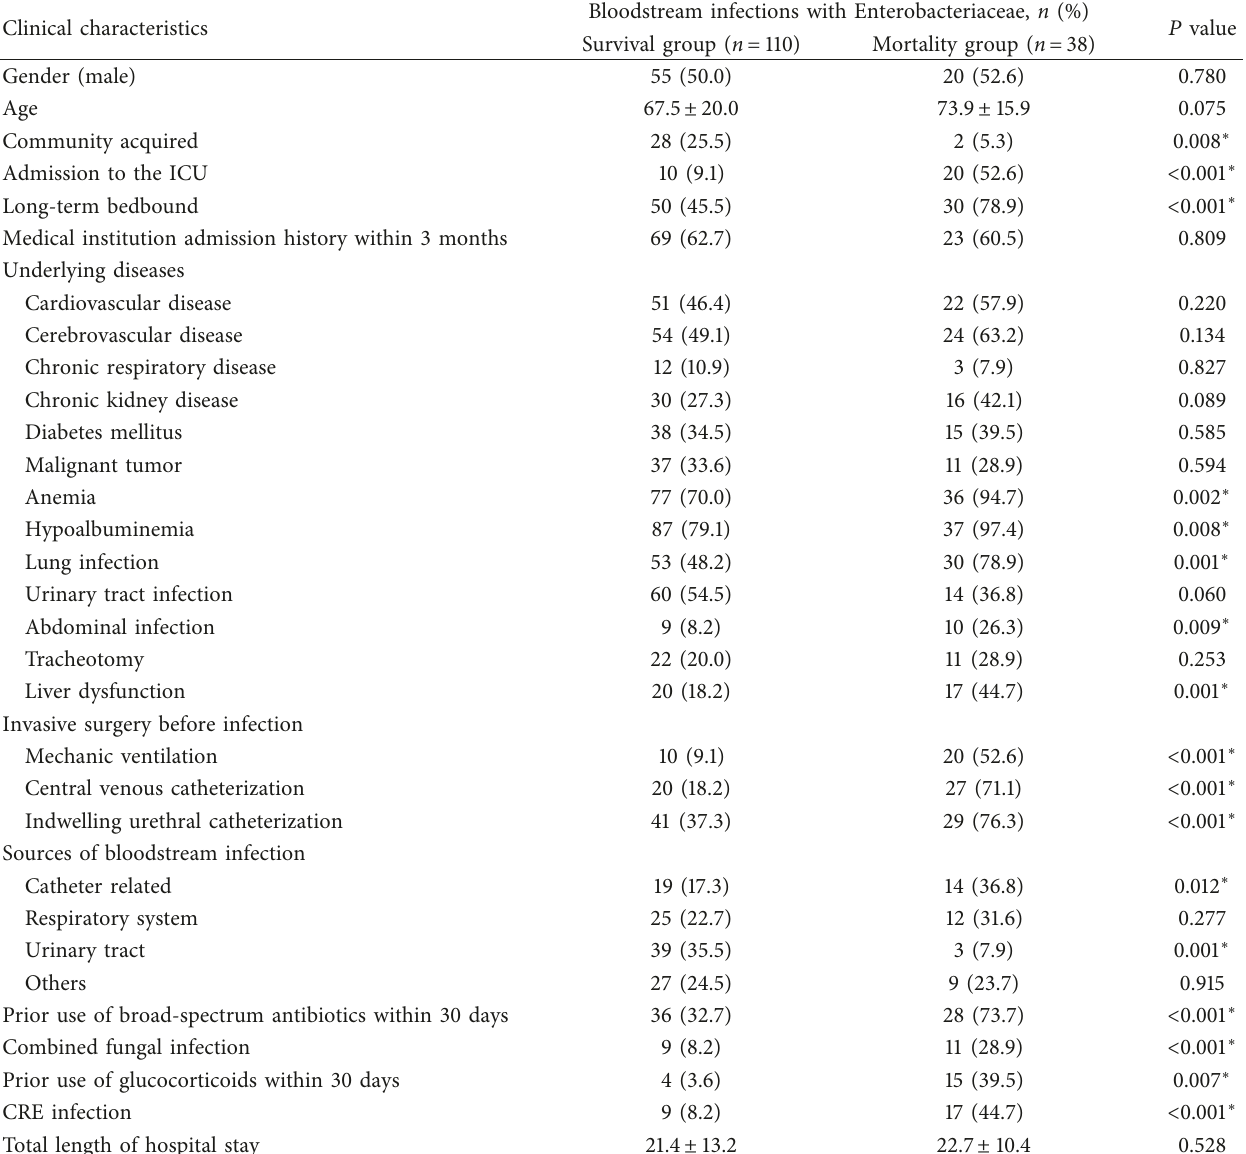
Table 3: Univariate analysis for predictors of mortality caused by bloodstream infections with Enterobacteriaceae. Clinical characteristics